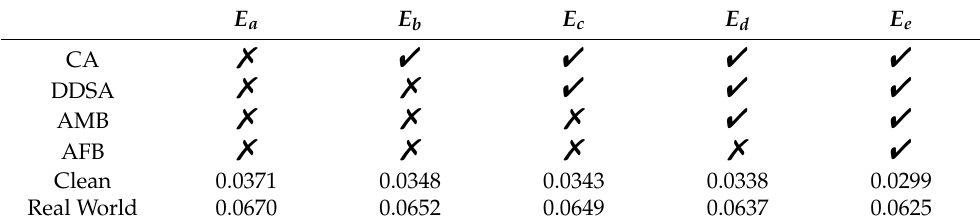
Table 5. Effects of different ingredients in the proposed